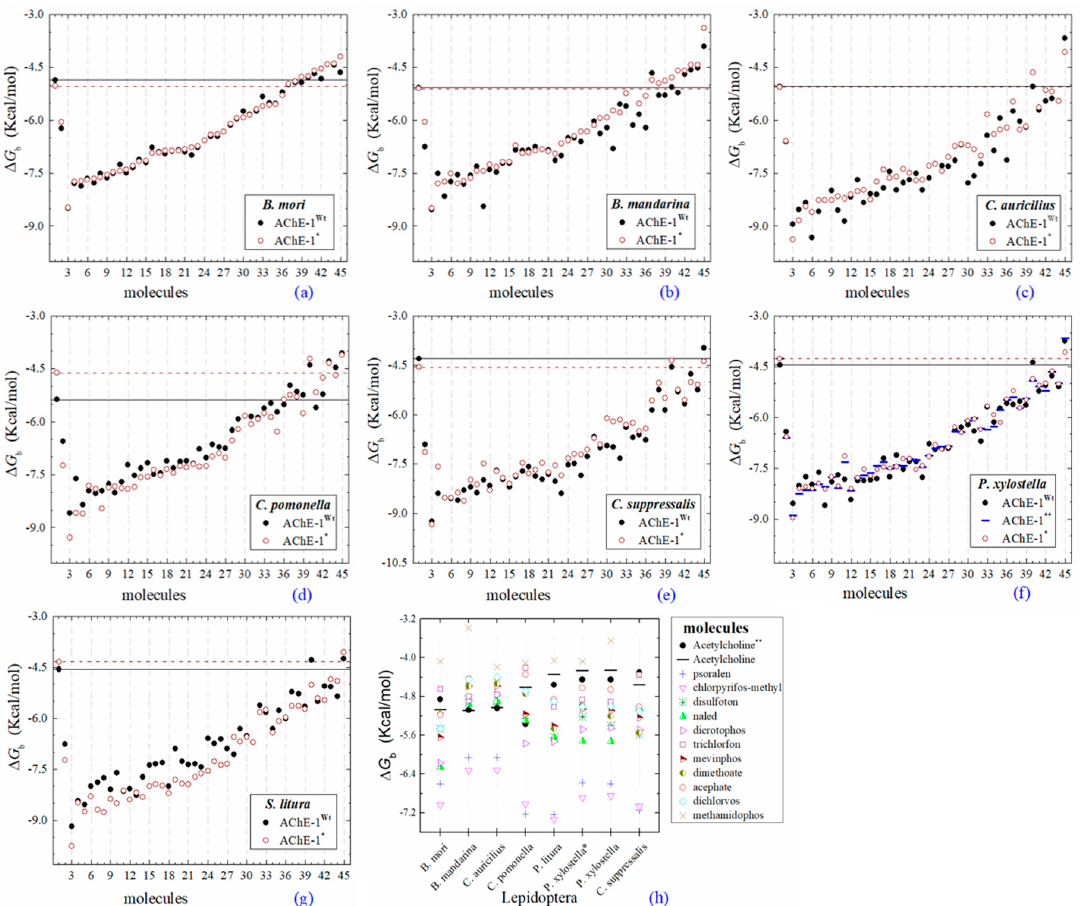
Figure 4. Predicted ∆ G b results of OPs molecules in AChE-1 ( Wt , wild type, full circles in a – g , and, *, modified, empty circles in a – g ). ∆ G b , estimated free energy of binding; point mutations on AChE-1: A201S, G227A, and L452S to B. mori ( a ) and to B. mandarina ( b ); A201S to C. auricilius ( c ) and to C.